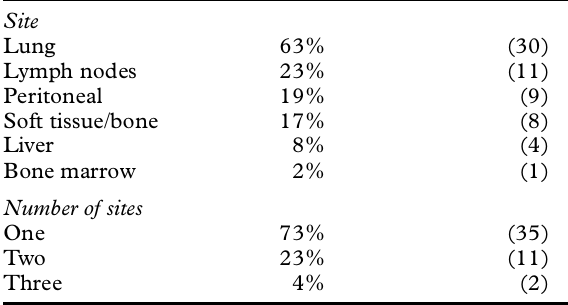
Table 2 . Characteristics of the metastatic tumor in 48 patients with a soft tissue sarcoma and synchronous metastases